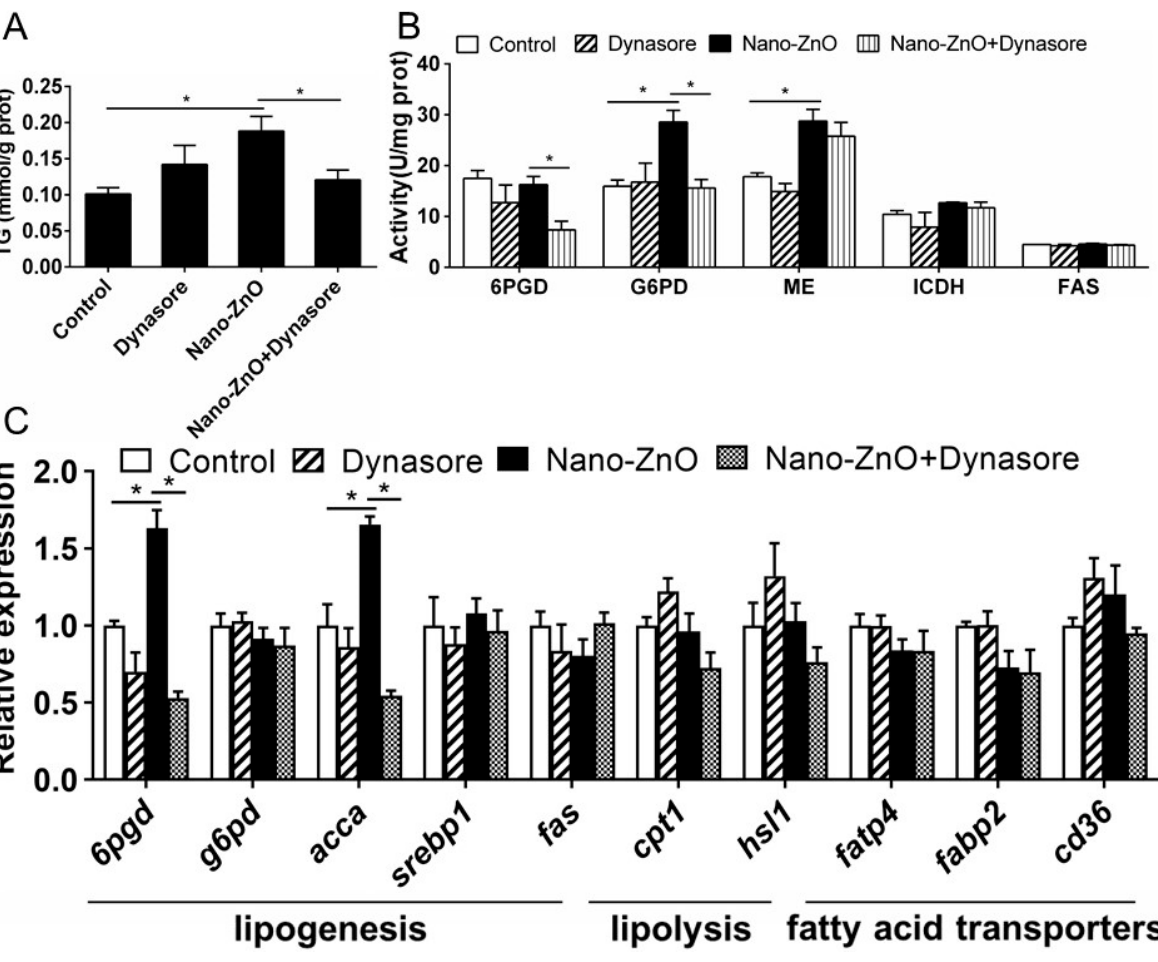
Figure 6. Effects of Nano-ZnO and Dynasore incubation on TG contents, enzymatic activities, and gene expression of yellow catfish IECs. ( A ) TG content. ( B ) Enzyme activities. ( C ) The mRNA expression of lipid metabolism genes. Asterisks (*) indicate the significant differences between the two treatments ( p < 0.05). For each value, three biological replicates are undertaken.